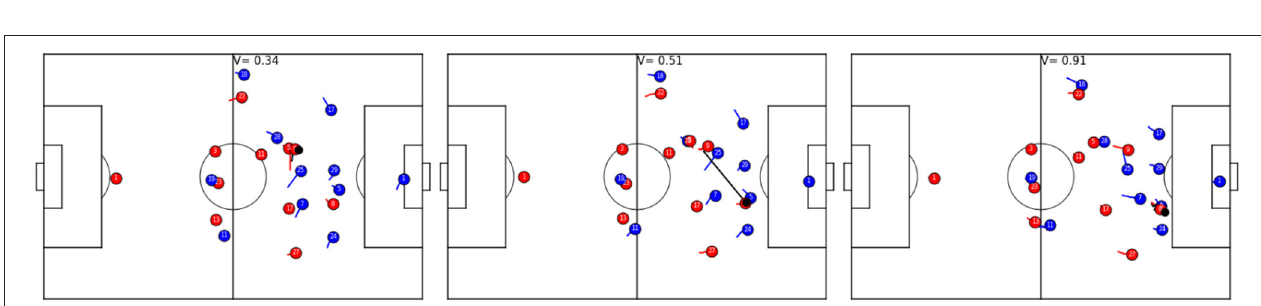
FIGURE 6 | Temporal development of the V for a dribble. Red is attacking from left to right. Player 8 receives a pass from the left-wing; blue player 24 moves toward ball, V = 0.16 (Left) . Blue player 24 attacks the ball carrier, though from a non-optimal angle, yielding V = 0.24 (Center) . The ball-possessing player dribbles past the defender and the V jumps to V = 0.45 (Right) .